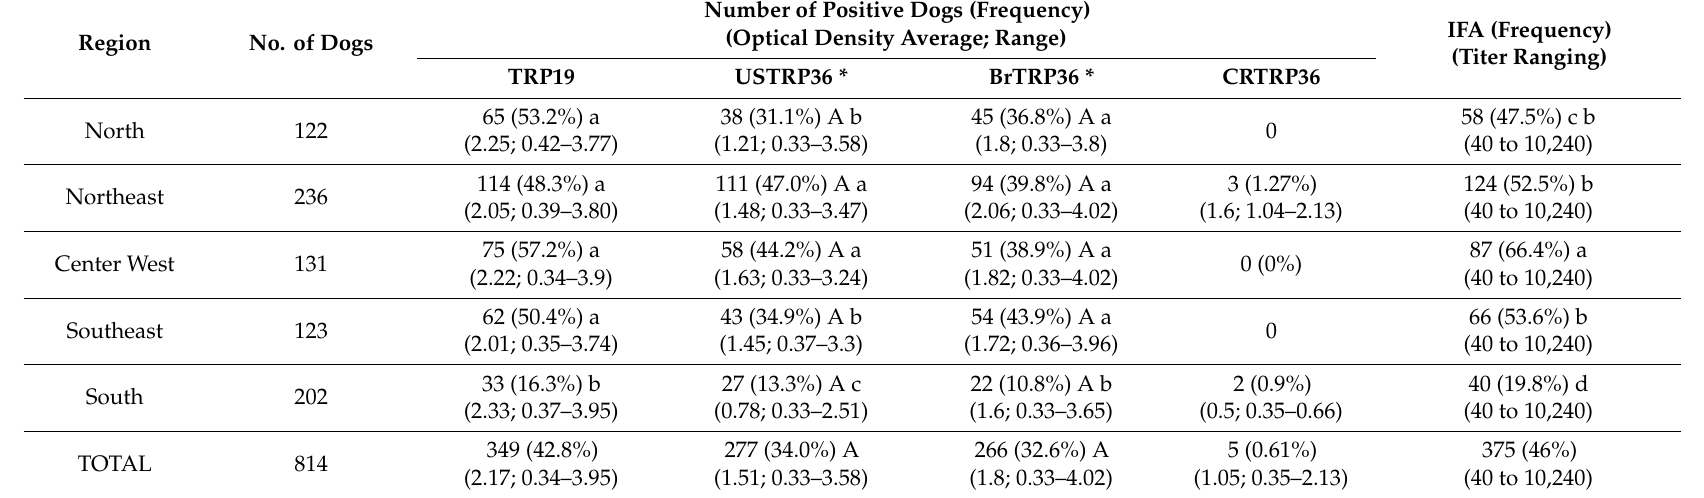
Table 2. Number and frequency of seropositive dogs according to serological assays, average and range of optical density by Tandem repeat proteins (TRPs) ELISA and titer range in